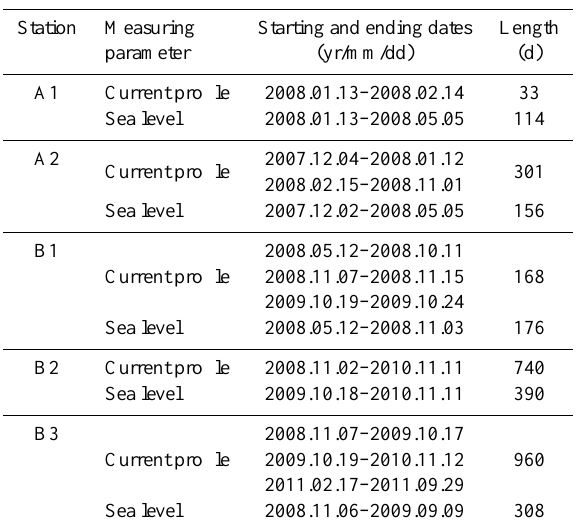
Table 2. Record length of the obtained